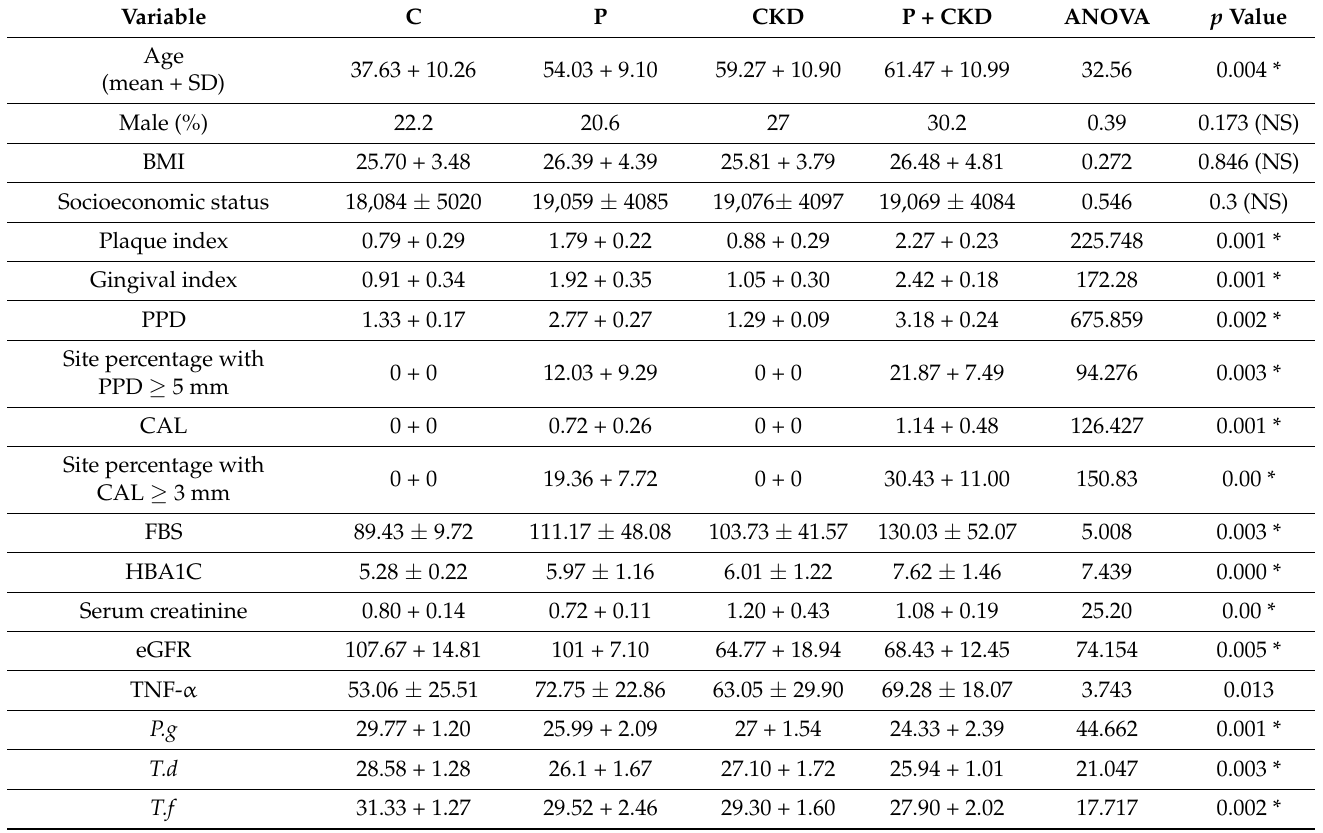
Table 1. Comparison of demographic variables, renal, periodontal parameters and levels of red complex bacteria among